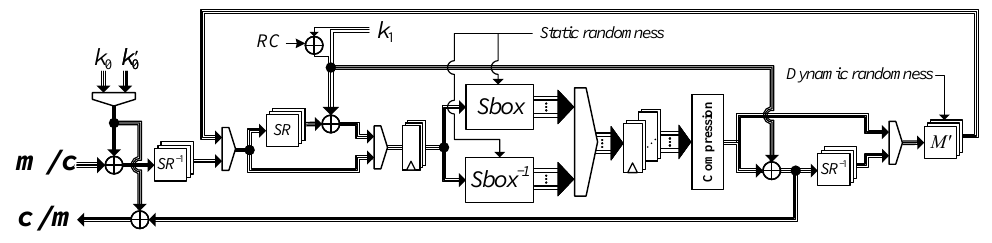
Figure 6: Design architecture of our round-based second-order Prince encryp- tion/decryption